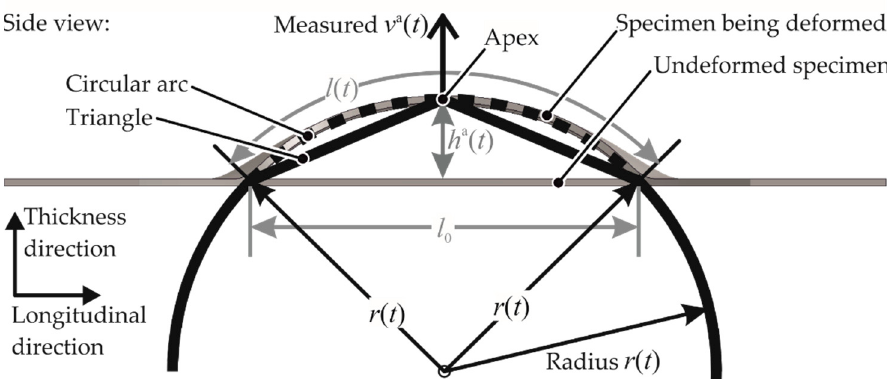
Figure 10. Apex velocity v a ( t ) was measured during each experiment. h ( t ) denotes apex height, l ( t ) denotes specimen length.